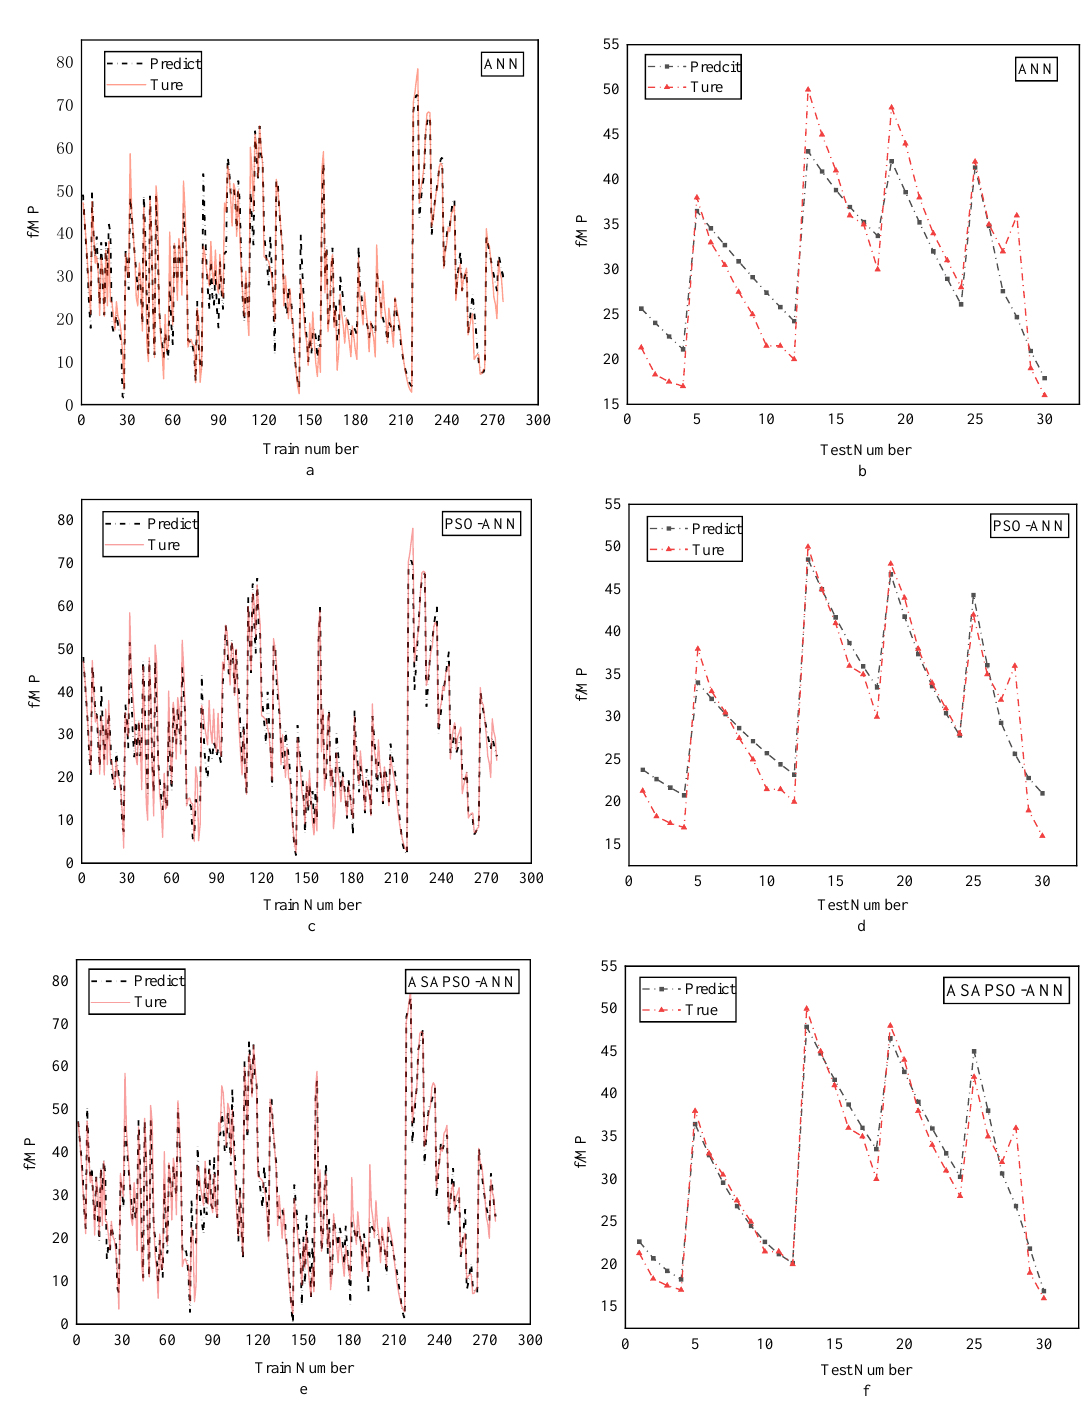
Figure 8. Comparison of actual and predicted values for the three models: ( a , b ) for ANN model; ( c , d ) for PSO-ANN model; ( e , f ) for ASAPSO-ANN model, for training and testing phases, respec- tively.